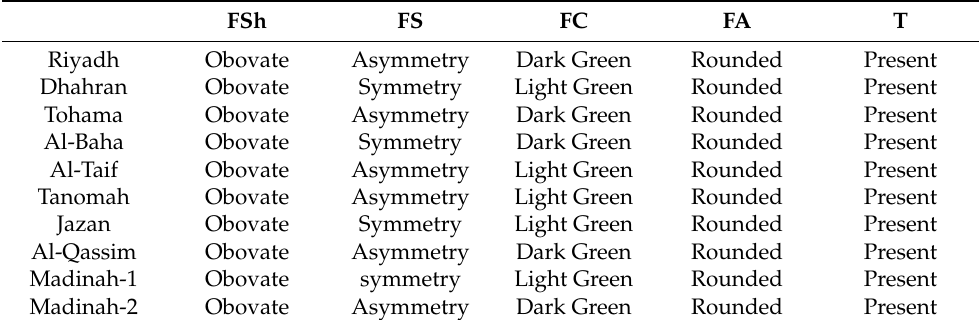
Table 2. Analysis of variance (ANOVA) for the quantitative morphological traits of the studied duckweed clones. Mean and standard deviation of the evaluated traits ( n = 10 samples and three replications, total = 30).